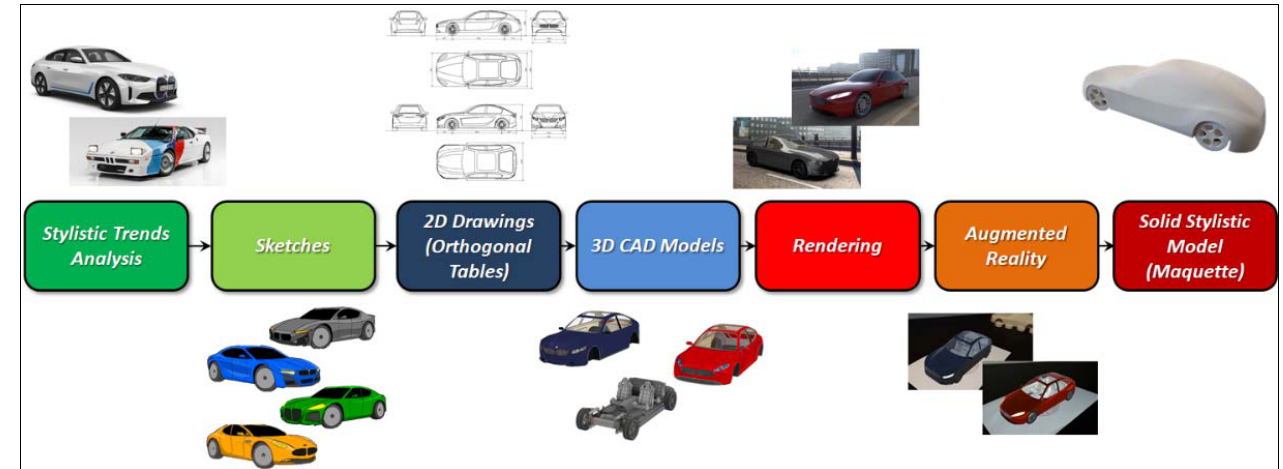
Figure 23. Stylistic design engineering